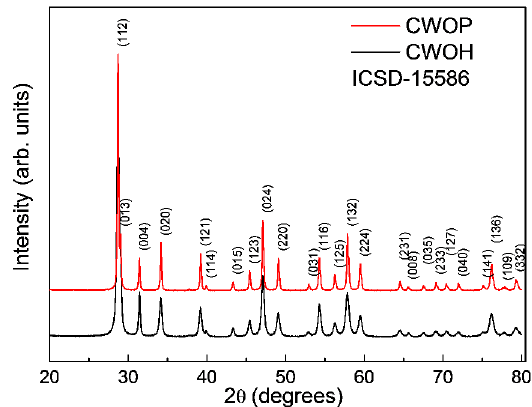
Figure 1. XRD patterns of CWOH and CWOH